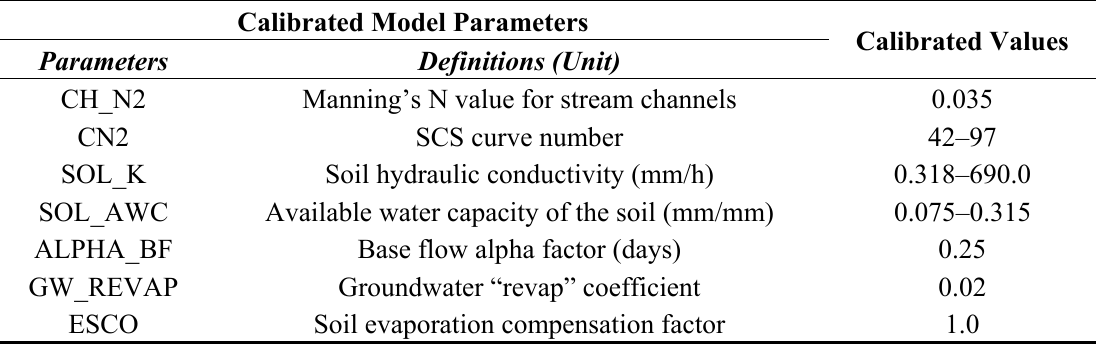
Table 1. Model parameters used to calibrate discharge at